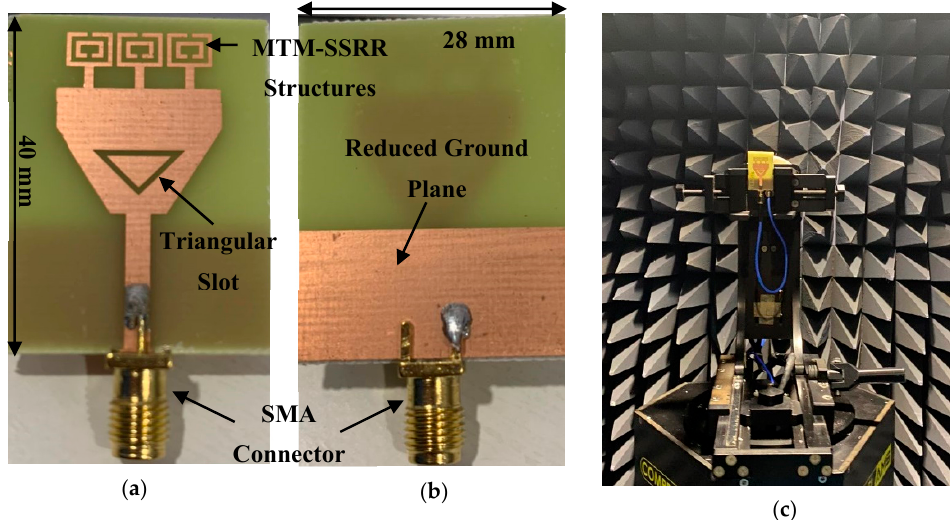
Figure 10. Fabricated Prototype of Proposed Antenna ( a ) Top-layer ( b ) Bottom-layer ( c ) Anechoic chamber measurement setup.